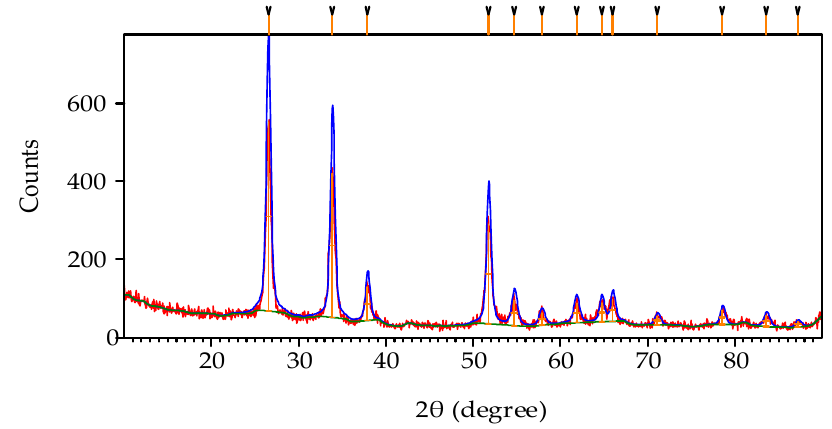
Figure 4. XRD pattern showing the peaks that matched the product to be SnO 2 .